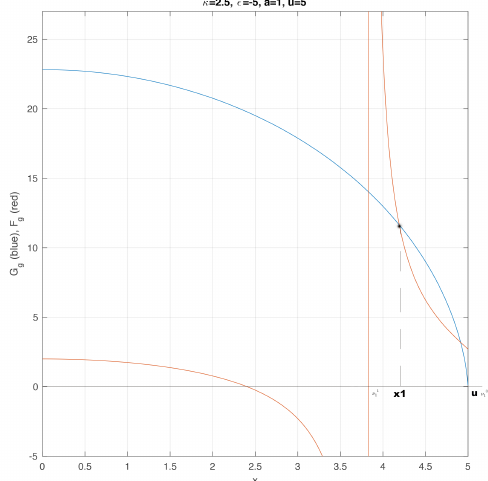
Figure 2: Graphs show the location of the first two roots of